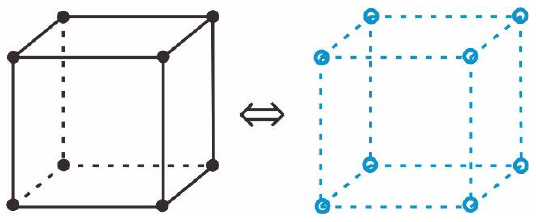
Figure 1. Duality between the 3D Ising model and the 3D Z 2 lattice gauge model.